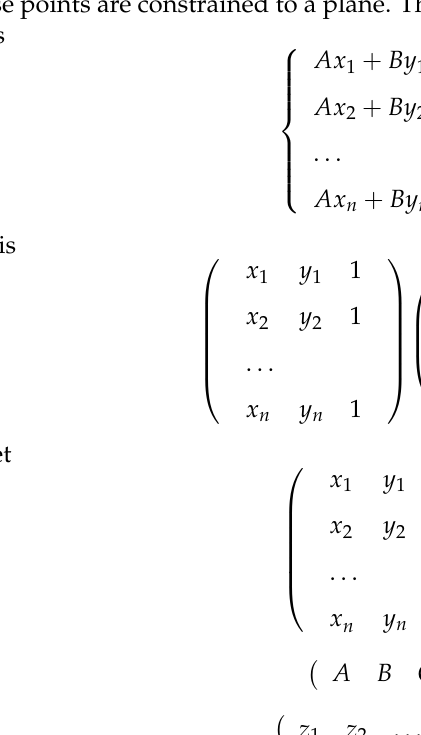
( x ) . . . . . . ( x ) . These measurement points are all located on the same n , y n , z n 2 , y 2 , z 2